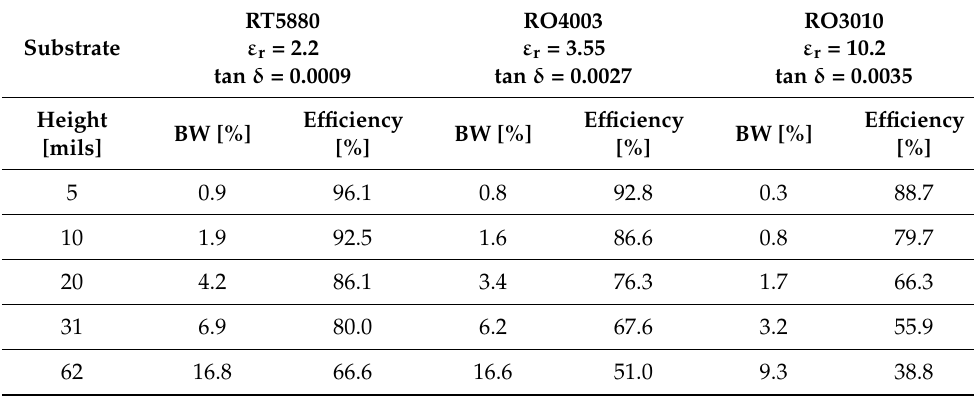
Table 1. Comparison of single MPA on different substrates for Bandwidth and